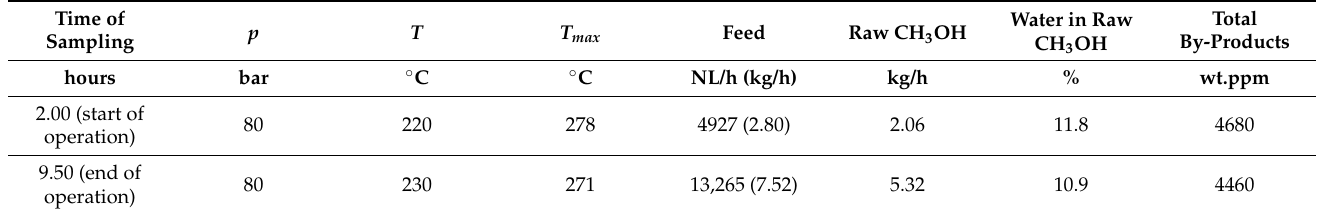
Table 5. SC2. By-product amount in raw methanol from ALFE_CH3OH_PLP at different feed